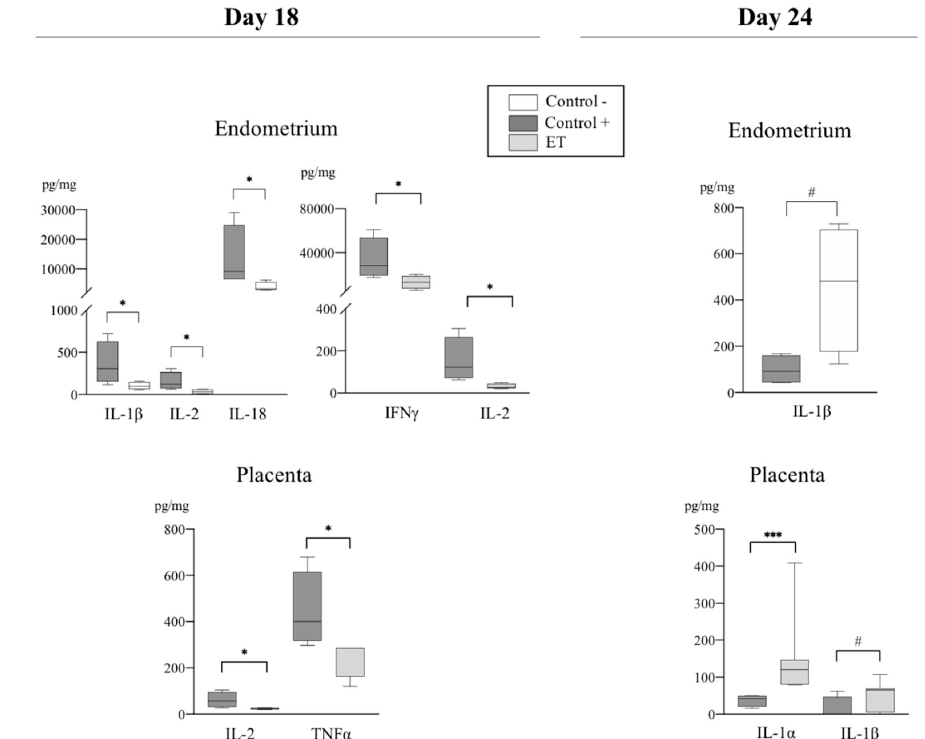
Figure 3. Relative abundance of pro-inflammatory cytokines (pg/mg of total protein) among experimental groups (C+, C-, and ET) at Day 18 and Day 24 of pregnancy in samples from endometrium and placenta. Data are presented by box plot showing median and inter-quartile range (Q1-Q3). Asterisks indicate significant differences among groups (* p < 0.05; *** p < 0.001; # Tendency p < 0.07).